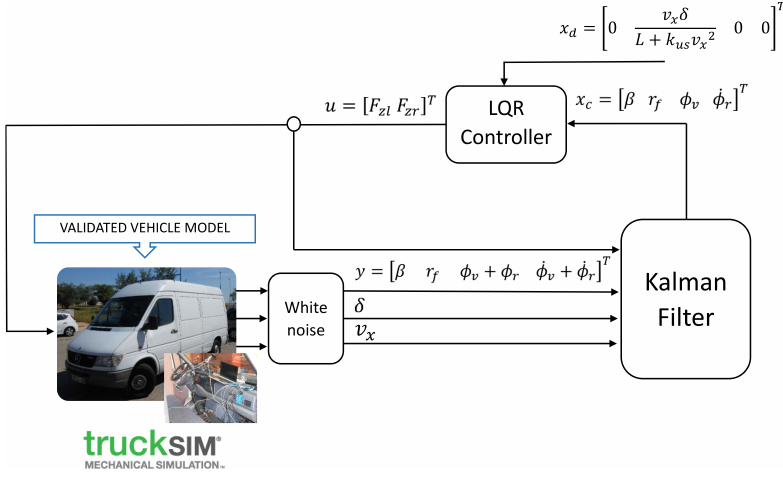
Figure 5. Controller